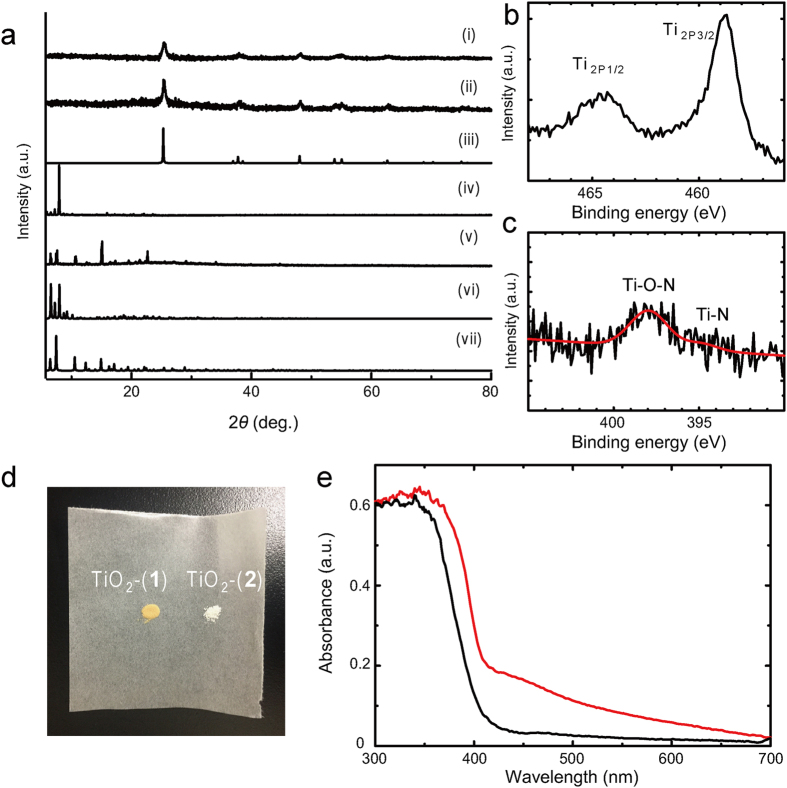
Spectroscopic characterization of TiO2-(1) and TiO2-(2).(a) PXRD of (i) TiO2-(1), (ii) TiO2-(2), (iii) Simulated TiO2, (iv) 1, (v) 2, (vi) simulated 1 and (vii) simulated 2. (b–c) XPS spectra of TiO2-(1) for Ti2p and N1s with fitting curves (red). The whole spectra is shown in supplementary information. (d) Photograph of TiO2-(1) and TiO2-(2), (e) UV-vis absorption spectra of TiO2-(1) (red) and TiO2-(2) (black).